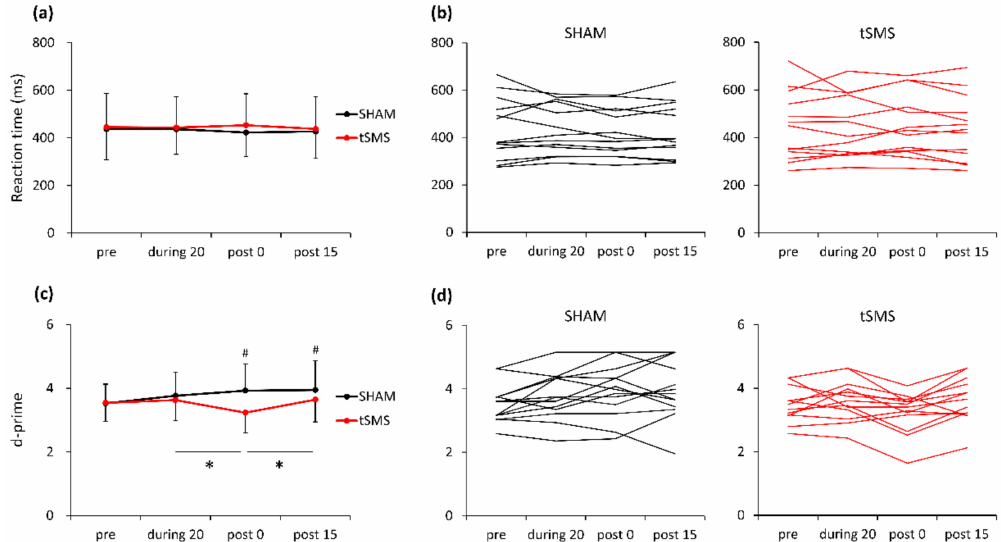
Figure 2. Mean and individual values of reaction time ( a , b ) and d-prime ( c , d ). * p < 0.05 during 20 vs. post 0 and post 0 vs. post 15, # p < 0.05 tSMS vs. SHAM at post 0 and post